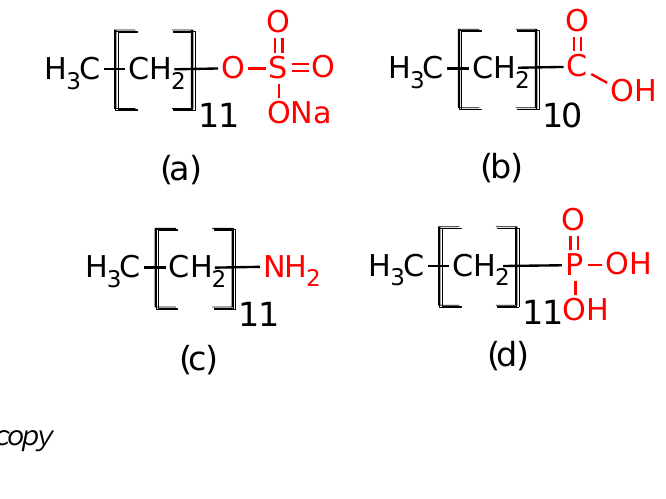
Figure 2. Four surface capping molecules used for titania ( a ) sodium dodecyl sulfate; ( b ) dodecanoic acid; ( c ) dodecyl amine; ( d ) dodecyl phosphonic